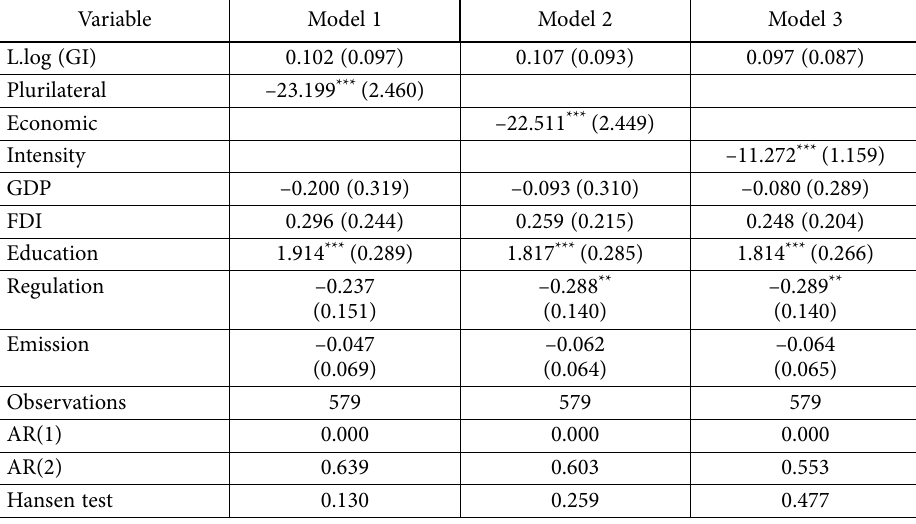
Table 1. Estimation results of the GMM model (Dependent variable: Green inventions)